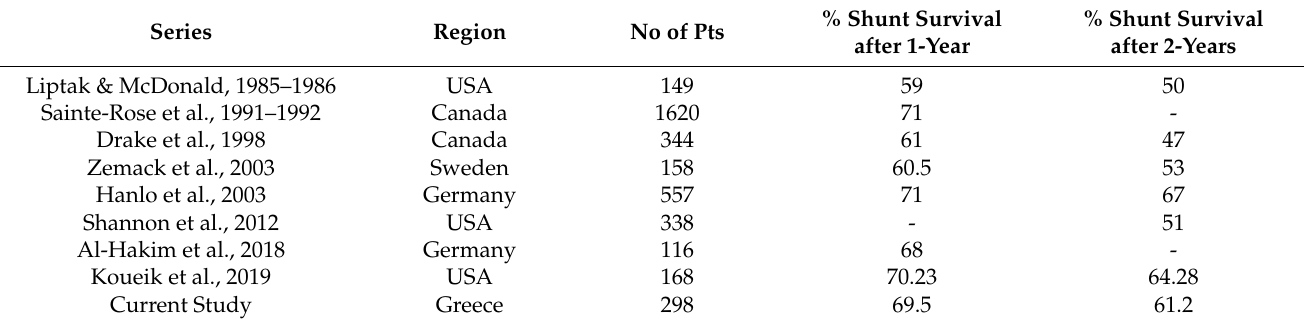
Table 3. Summary of 1- and 2-year shunt failure rates in different published shunt